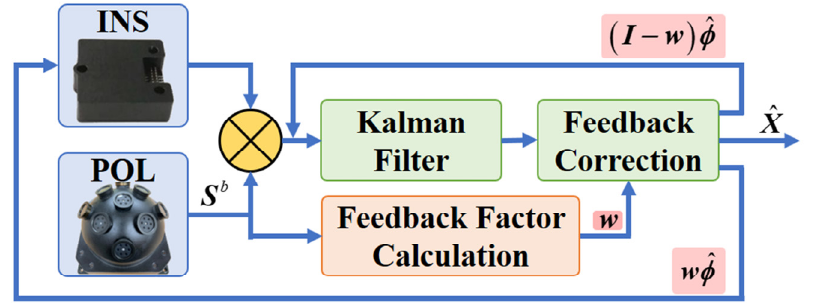
9 of 18 Figure 4. The yaw estimation ( a ) and yaw error ( b ) of SINS and INS/POL for different z γ . The red dash line is guide to eye.